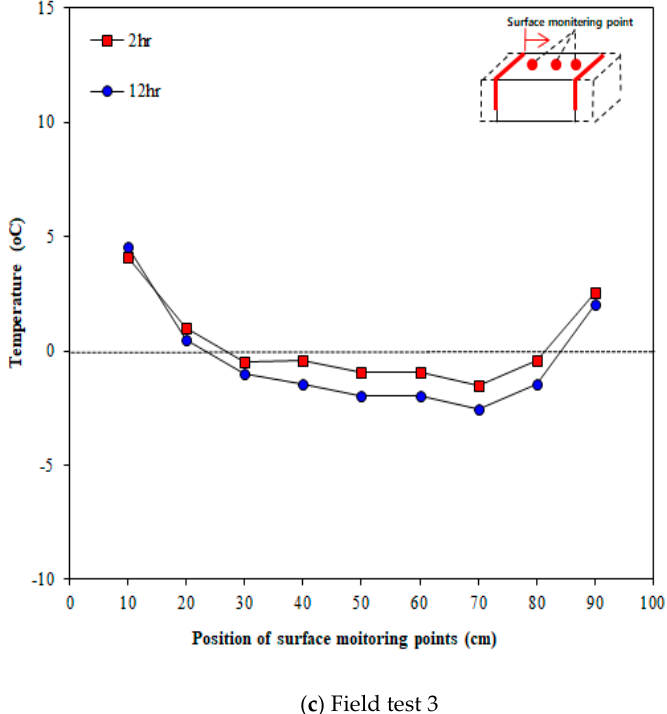
Figure 15. Temperatures at different surface locations measured at different times (Line 2).